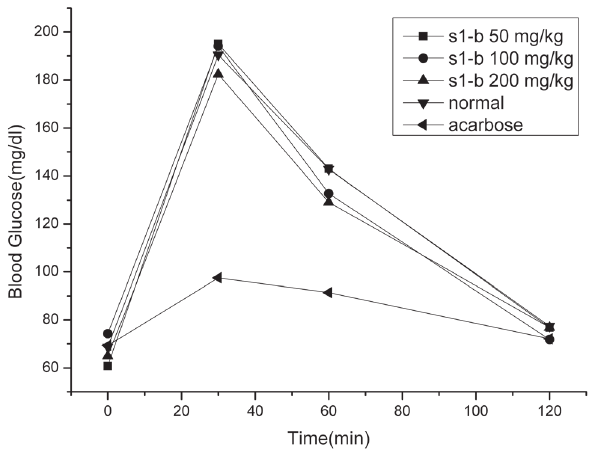
Figure 2. The influence of S1-b on blood glucose of normal ICR rat after sucrose loading. Acarbose (10 mg/kg of body weight); S1-b (50 mg/kg, 100 mg/kg, 200 mg/kg of body weight).